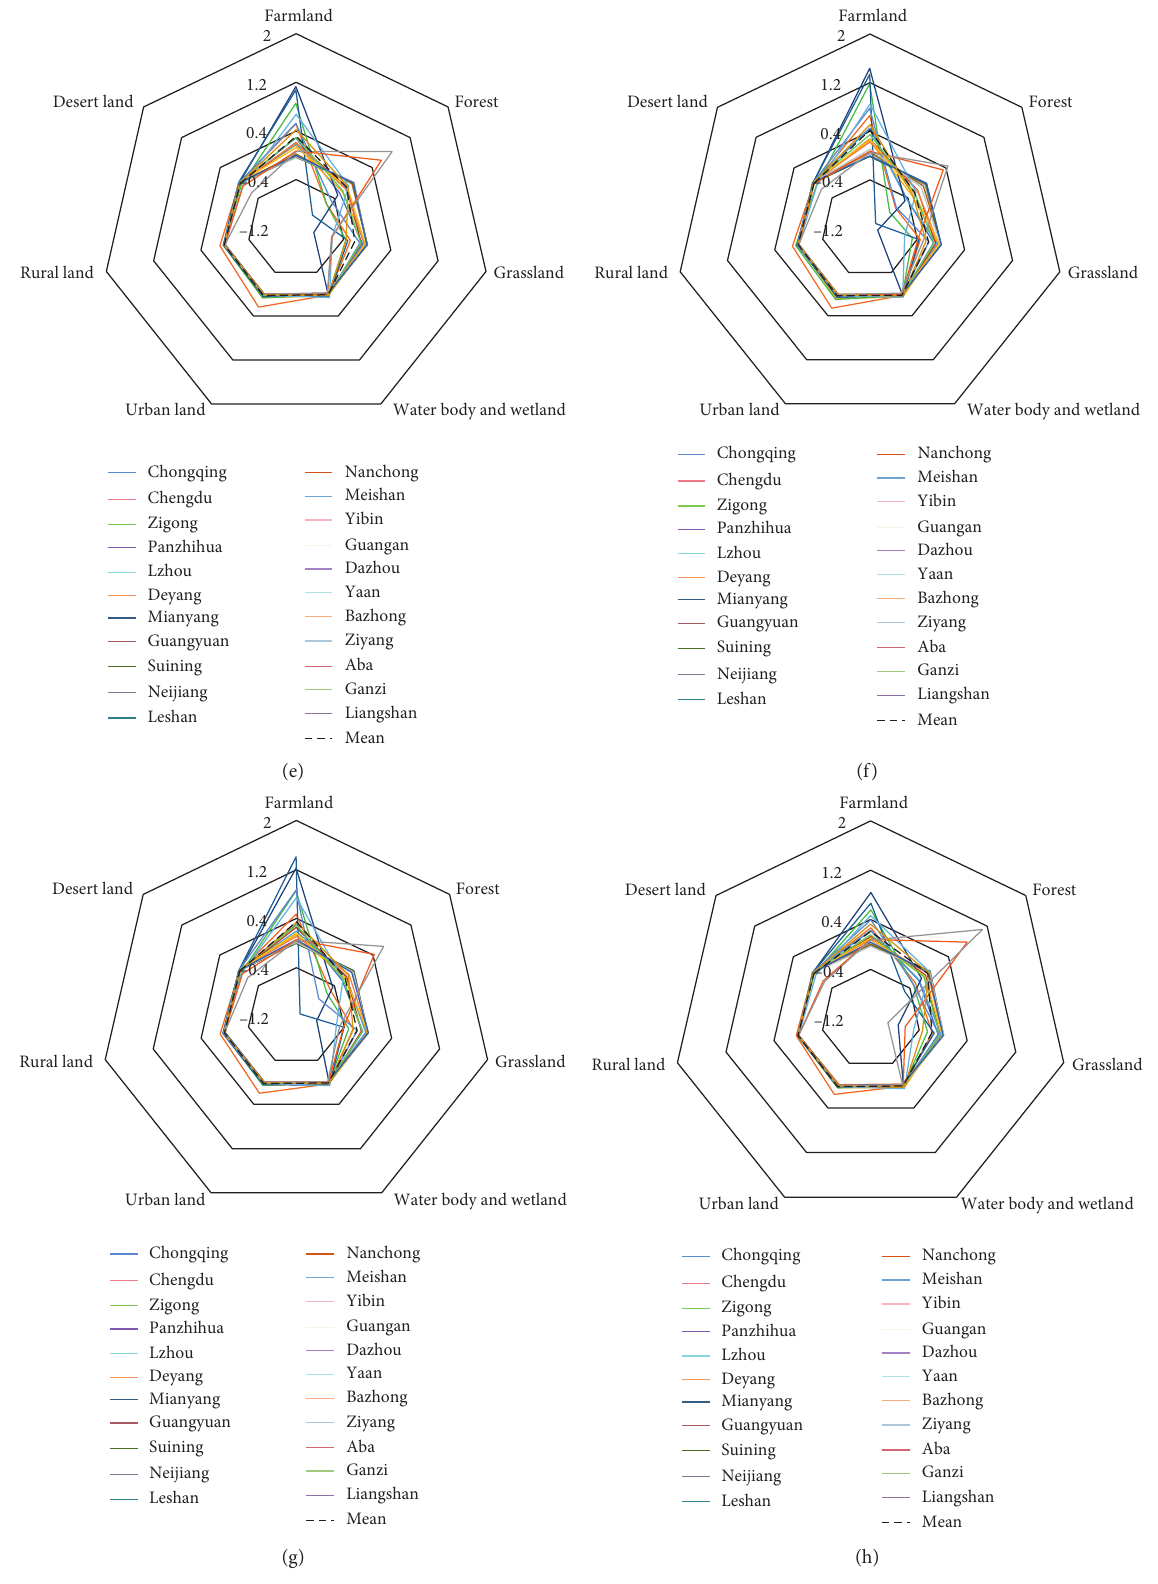
Figure 7: The CIs of ecosystem types for 22 cities in Sichuan-Chongqing region in 2015. (a) Spring daytime. (b) Summer daytime. (c) Autumn daytime. (d) Winter daytime. (e) Spring nighttime. (f) Summer nighttime. (g) Autumn nighttime. (h) Winter